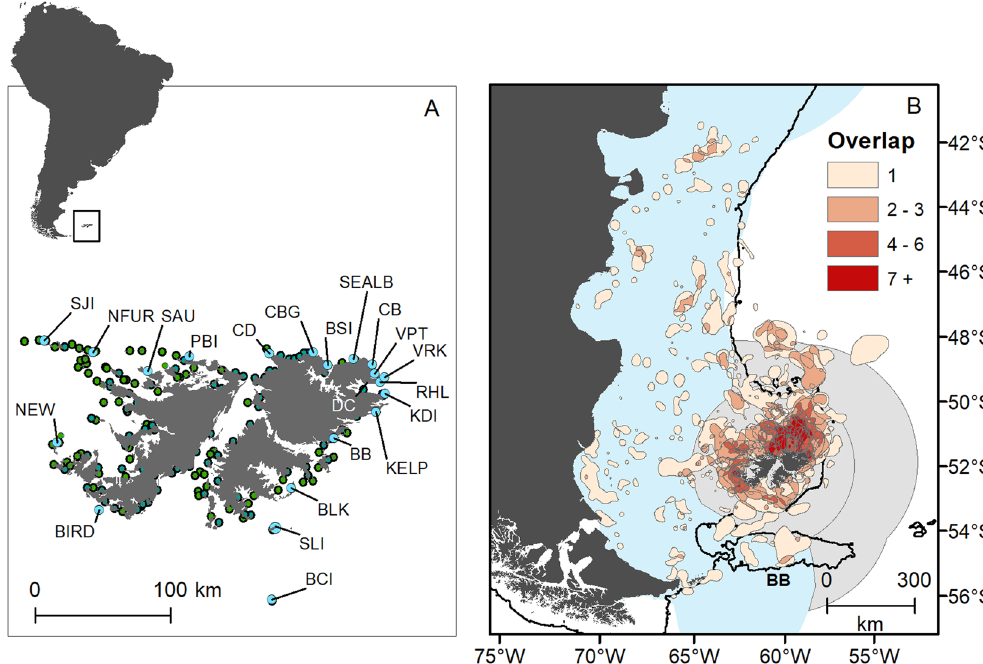
Figure 1. Panel (A) = locations of the 21 tracked breeding colonies (blue dots) at the Falkland Islands. Green dots are untracked colonies Panel (B) = important areas identified by overlap of 50% utilization distributions. Darker colours represent a higher number of overlapping utilization distributions. Thin black line is the 400 m bathymetric contour that marks the edge of the Patagonian Shelf, as well as the Burdwood Bank. Grey shading is the Falkland Islands Inner and Outer Conservation Zones, within which activities are managed and regulated by the Falkland Islands Government. Blue shading in the Argentinean Exclusive Economic Zone. SJI = Steeple Jason Island; NFUR = North Fur Island; SAU = Saunders Island; PBI = Pebble Island; CD = Cape Dolphin; CBG = Cape Bougainville; BSI = Big Shag Island; SEALB = Seal Bay; CB = Cow Bay; VPT = Volunteer Point; VRK = Volunteer Rocks; RHL = Rugged Hill; KDI = Kidney Island; DC = Diamond Cove; KELP = Kelp Island; BB = Berthas Beach; BLK = Bleaker Island; SLI = Sea Lion Island; BCI = Beauchene Island. BB = Burdwood Bank. Refer to Table 1 for details of the 13 groups for which utilization distributions are presented. Maps were created using R v3.5.2 and ArcMap